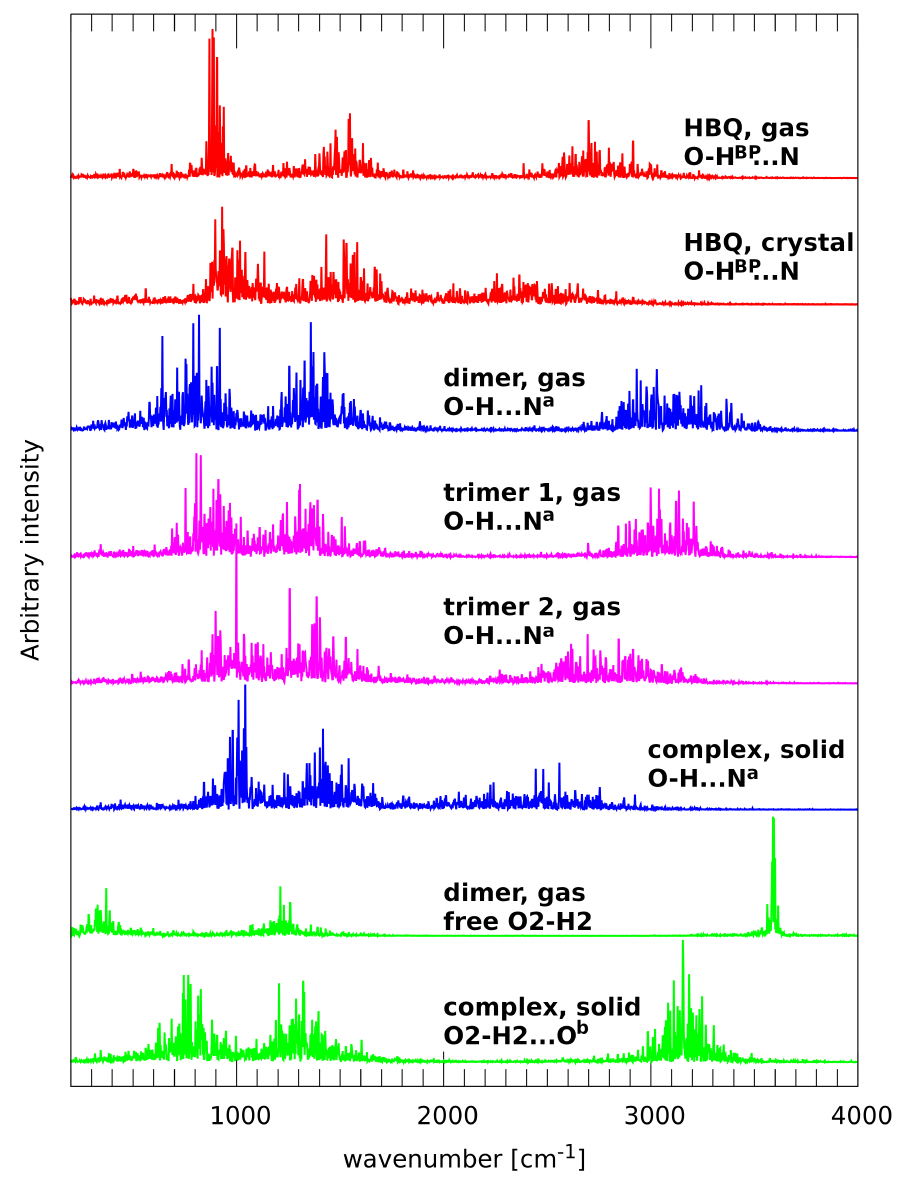
Figure 4. Vibrational signatures of the hydroxyl protons (hydrogen bridge protons with exception of the gas-phase heterodimeric complex of benzo[h]quinoline with 2-methylresorcinol, in which one of the -OH groups is